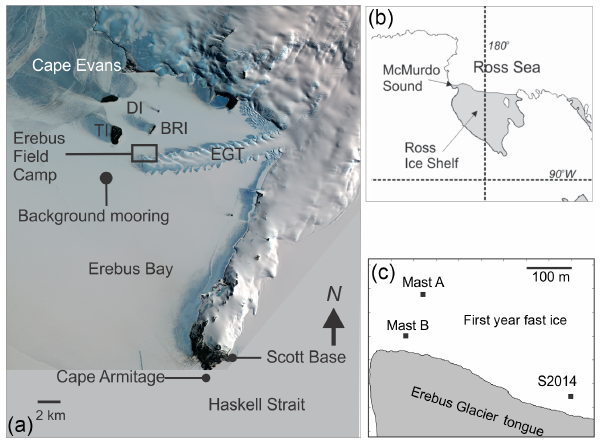
Figure 2. (a) Southwest McMurdo Sound image from ASTER (Ad- vanced Spaceborne Thermal Emission and Reflection Radiometer) satellite image of southeast McMurdo Sound including the Ere- bus Glacier tongue (EGT), the Dellbridge Islands (DI), Erebus Bay, Cape Evans, Cape Armitage, Haskell Strait, Scott Base, background mooring and the Erebus Field Camp. The Dellbridge Islands include Tent Island (TI) and Big Razorback Island (BRI). (b) The McMurdo Sound region, Antarctica, in the context of the Ross Ice Shelf and the Ross Sea, (c) Erebus Field Camp locale showing the turbulence mast locations relative to the edge of